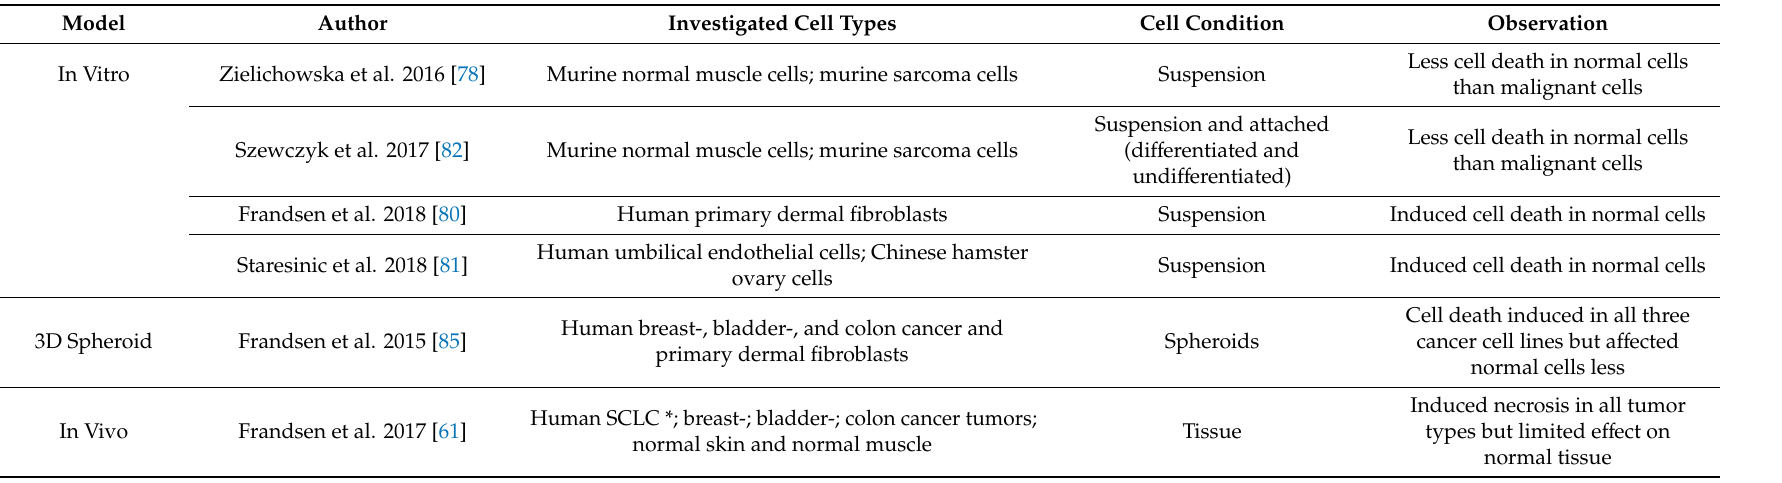
Table 1. Calcium electroporation of normal vs. malignant cells. Note the di ff erence between in vitro and in vivo